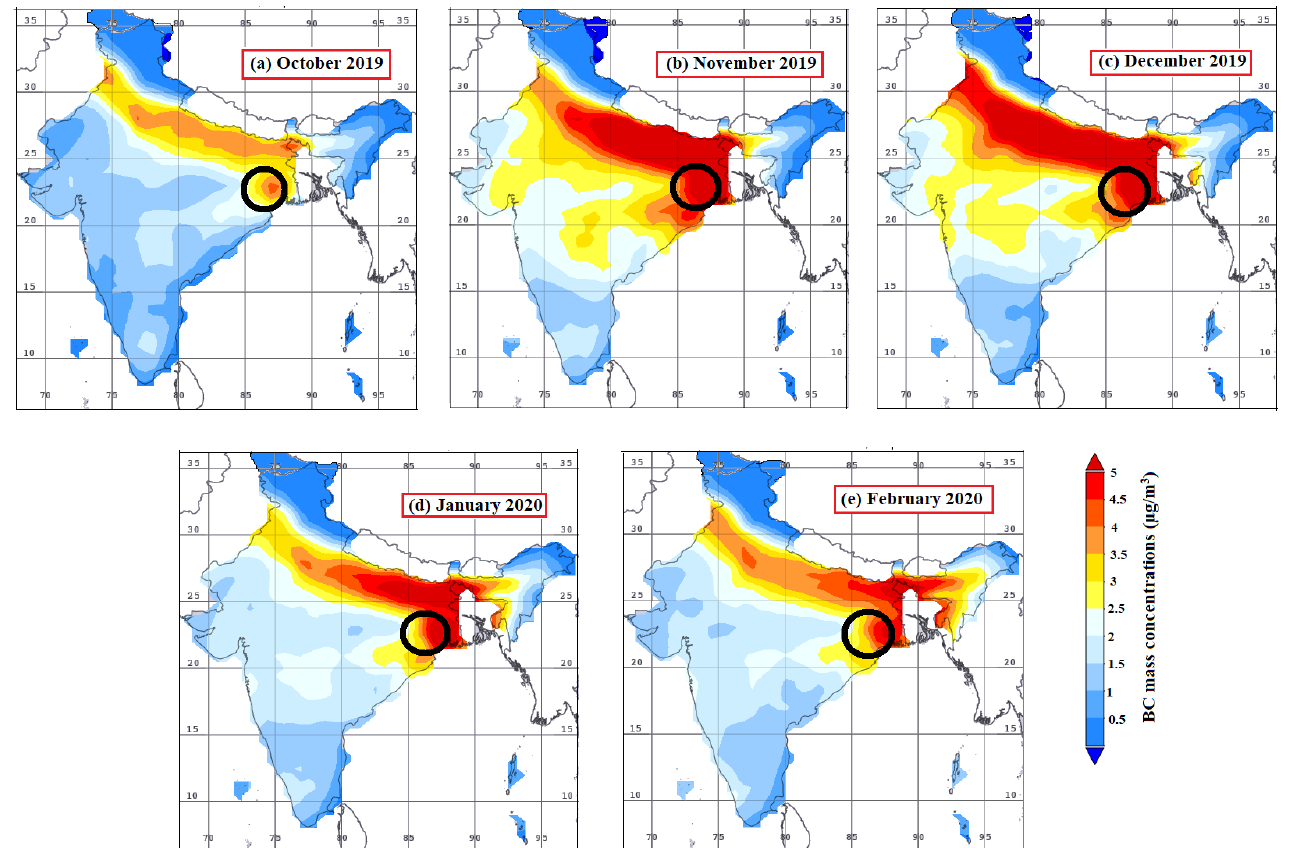
Figure 3. Time average maps of monthly BC surface mass concentration (µg/m 3 ) for ( a ) October 2019, ( b ) November 2019, ( c ) December 2019, ( d ) January 2020, and ( e ) February 2020 ( a – e ) (0.5 × 0.625 deg., MERRA-2 model M2TMNXAER v 5.12.4).